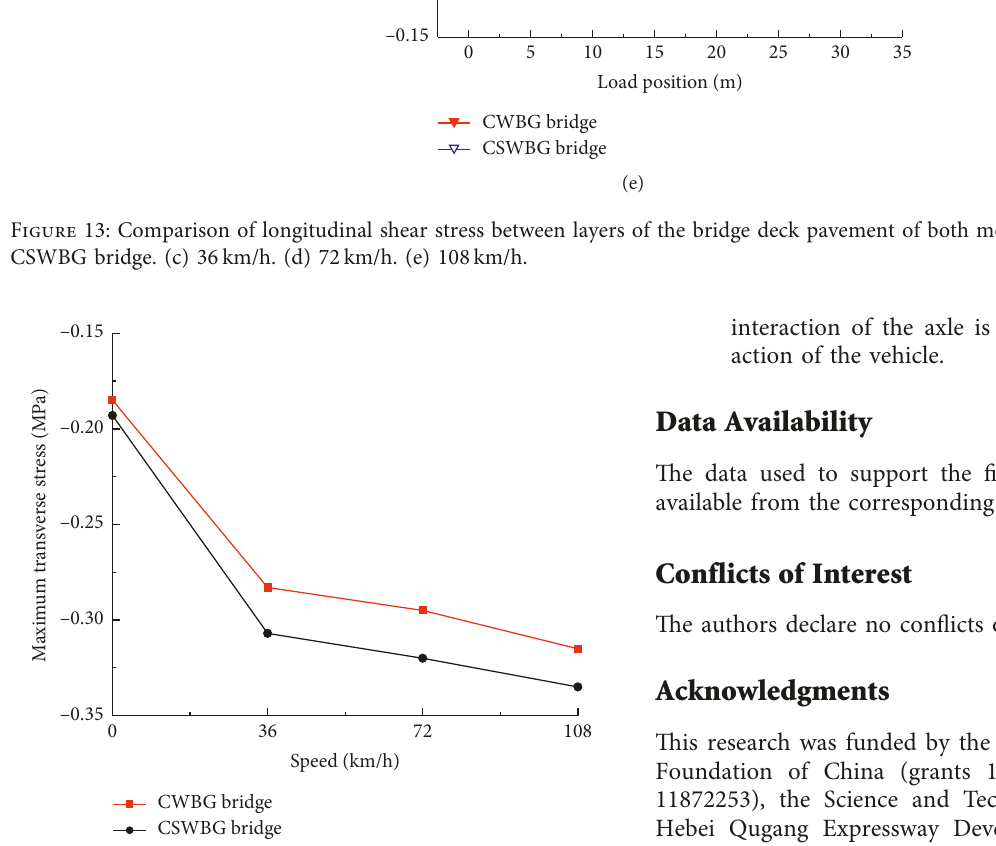
Figure 14: Comparison of maximum transverse stress on the surface of the bridge deck pavement under double wheel